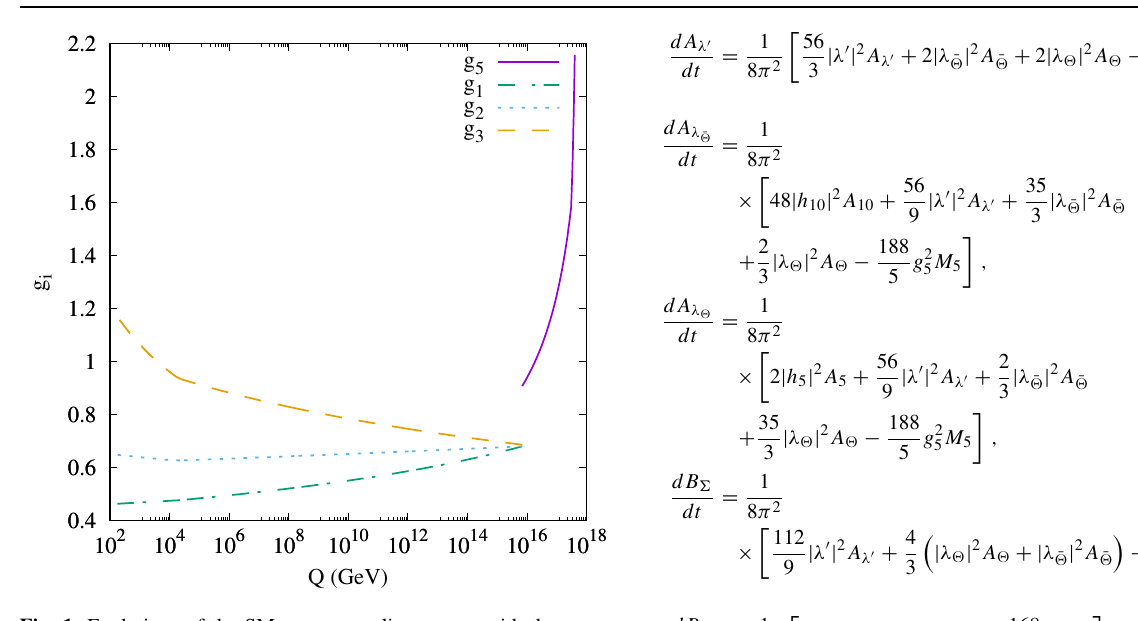
Fig. 1 Evolutions of the SM gauge couplings g 1 , 2 , 3 with the renor- malization scale μ below the GUT scale, exhibiting their unification and the rapid increase of g 5 above the GUT scale. We assume a bench- mark point with m 1 / 2 = 20 TeV: the values of the other benchmark parameters are specified in the